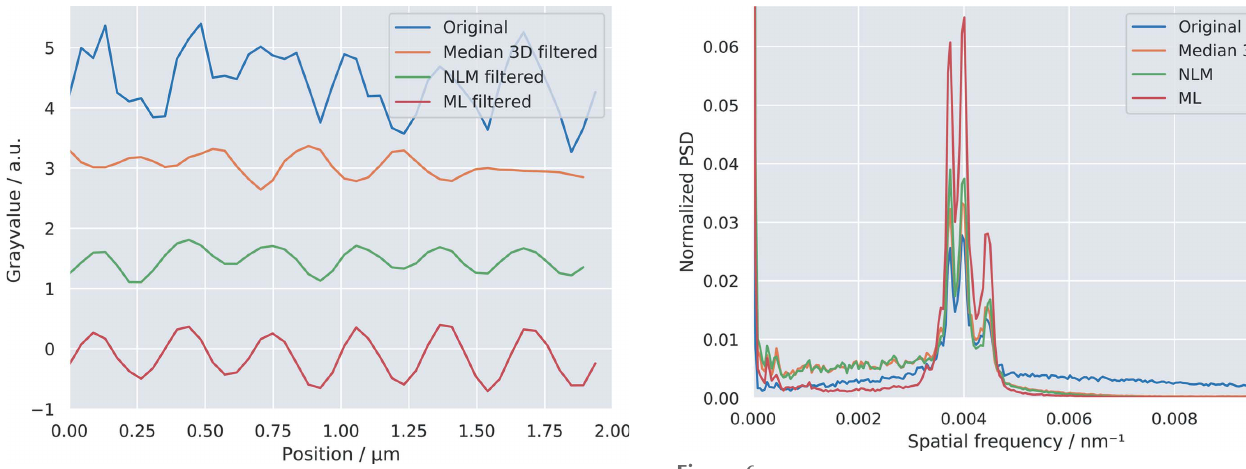
Figure 5 Line profiles along the dashed lines highlighted in the yz views found in the 2nd row in Fig. 4. The filtered profiles were shifted on the ordinate axis for better visibility of the periodic fine structure of the butterfly wing. While the median filter introduces a phase shift to the profile, the NLM filter and ML filter maintain the phase. The amplitude of the signal is best preserved with the ML filter.